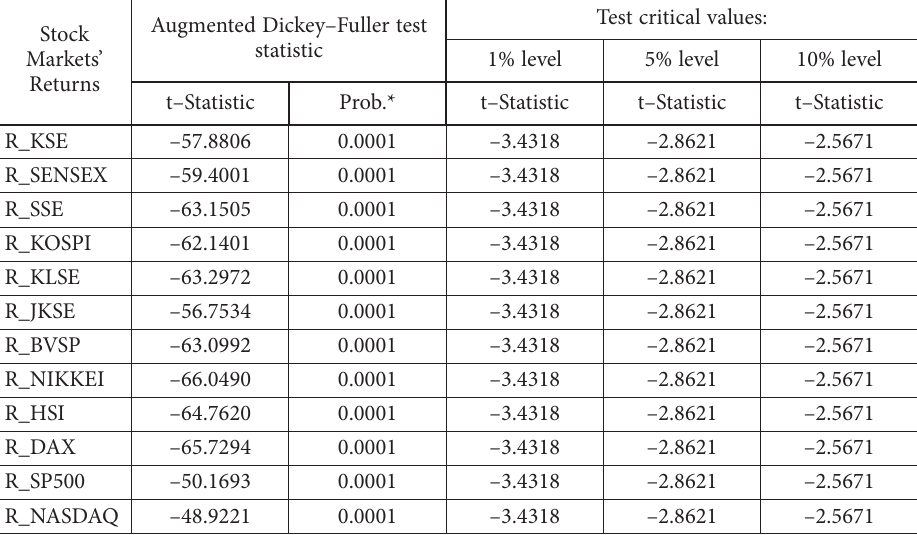
Table 4. Stationary test results for stock markets without